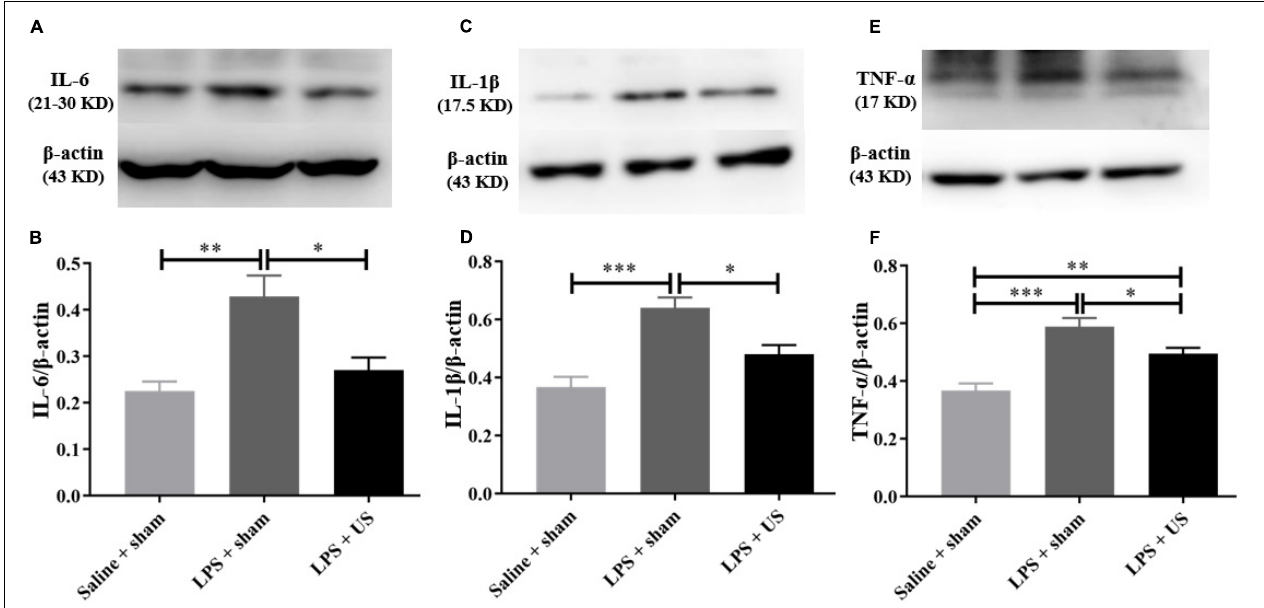
FIGURE 5 | Effect of US on inflammatory factors in the PFC. (A,C,E) Representative Western blots of inflammatory factors in the PFC (each line represents a single animal). LPS injection increases the levels of inflammatory factors in the PFC, and US treatment decreases the expression of IL-6 (B) , IL-1 β (D) , and TNF- α (F) in the PFC ( n = 6 in each group). US, ultrasound stimulation; PFC, prefrontal cortex; LPS, lipopolysaccharide. * p < 0.05; ** p < 0.01; *** p <